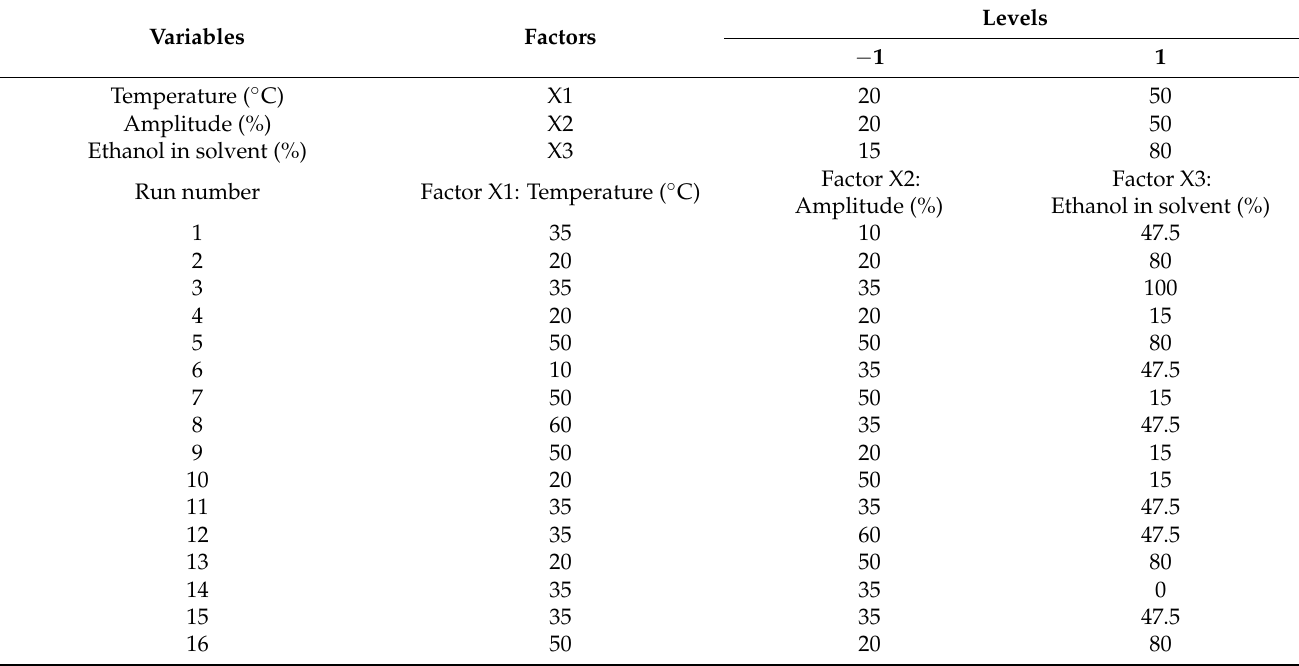
Table 1. UAE central composite design (CCD) for three independent variables: amplitude (%), ethanol volume % in solvent ( v / v ) and temperature ( ◦